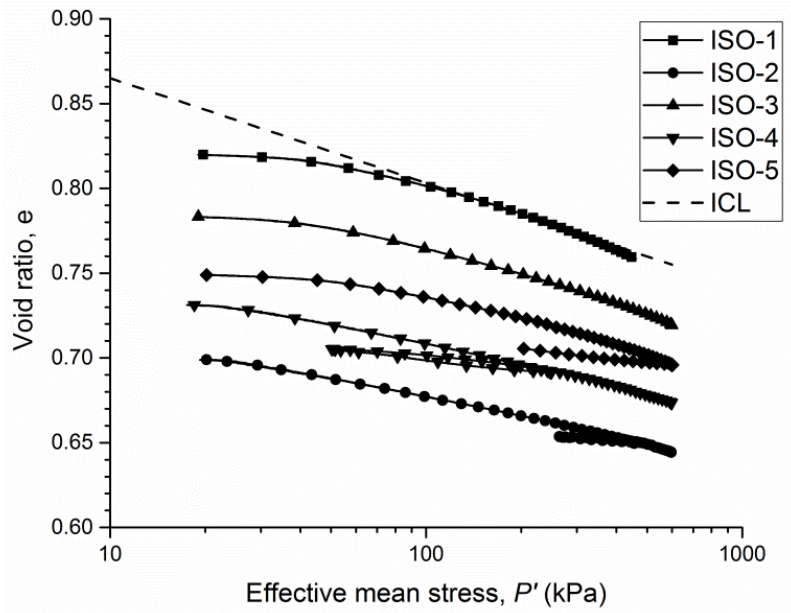
Figure 4. Isotropic compression response of the intact soil.